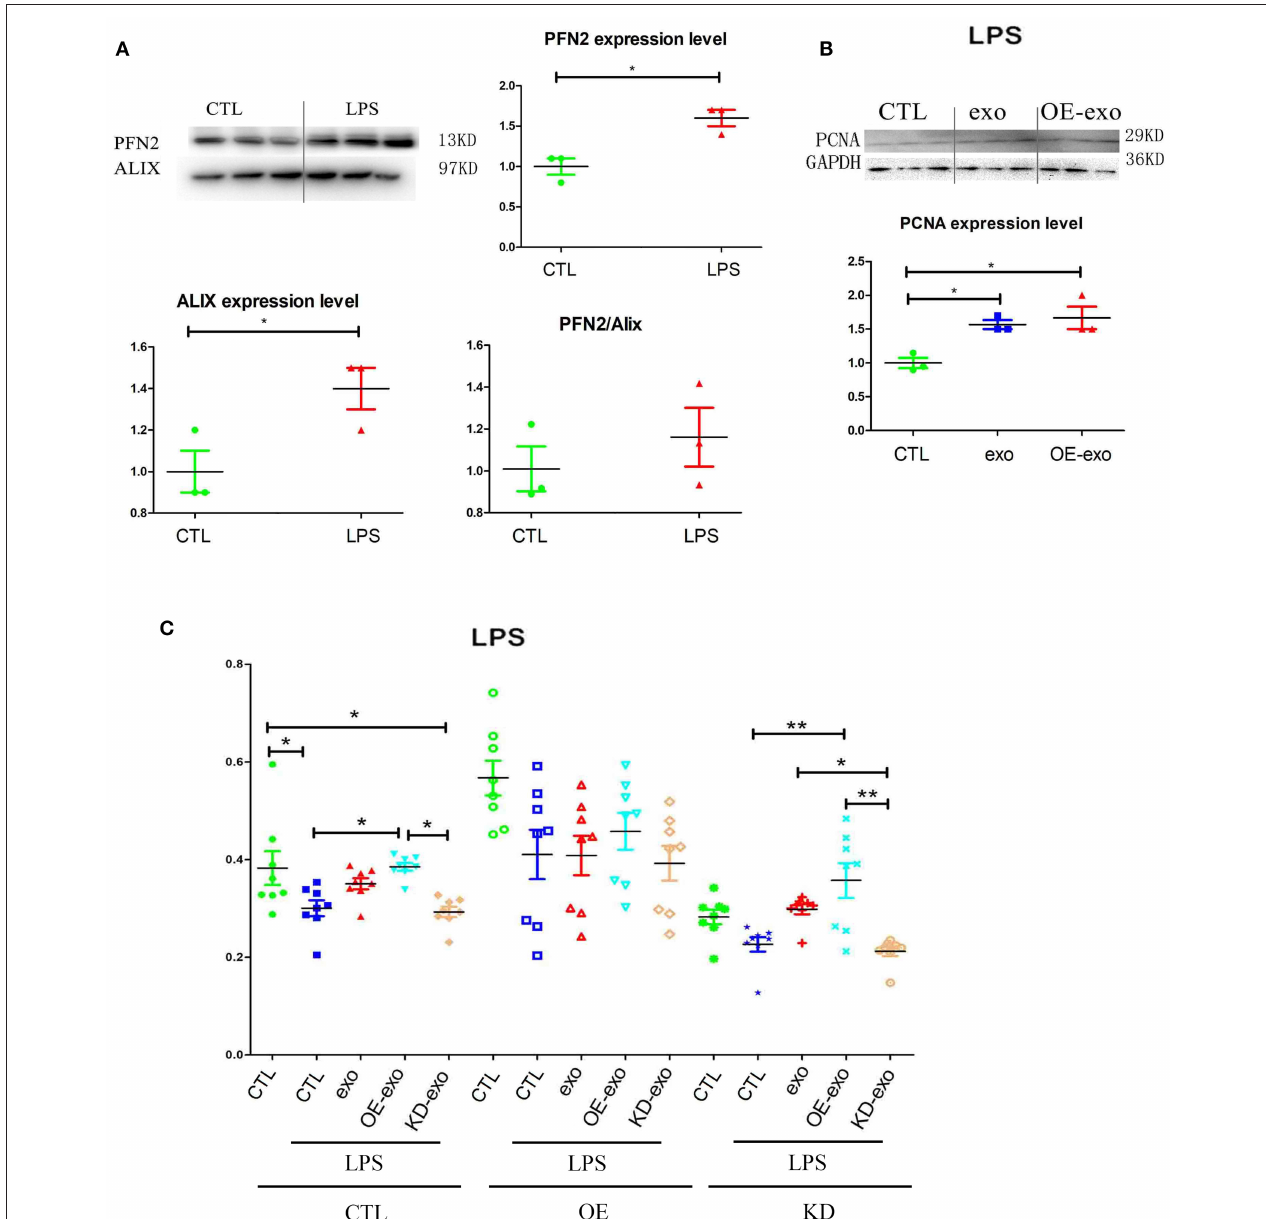
FIGURE 3 | PFN2 protects ECs after LPS treatment. (A) PFN2 and Alix expression levels in LPS-treated EC exosomes, n = 3, normalized to control. (B) PCNA expression levels of ECs under LPS stimulus after treatment with various exosomes, n = 3, normalized to control. (C) Viability of ECs under LPS stimulation after treatment with various exosomes. n = 8. * p < 0.05, one-way ANOVA